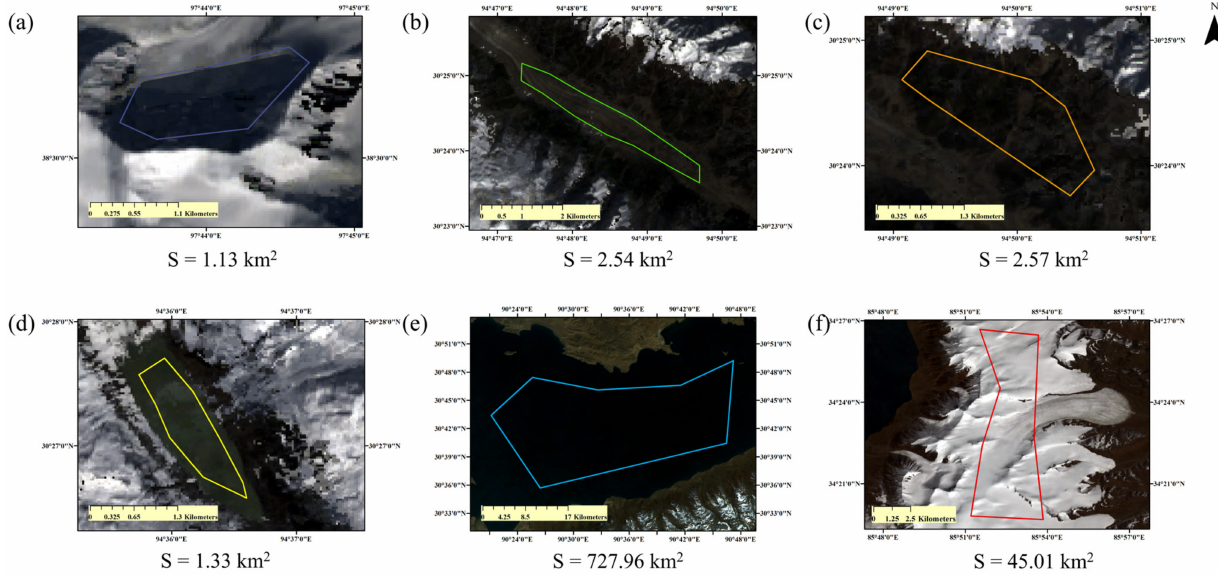
Figure 4. Sample collection of similar ground objects. ( a – f ) indicate shadow glaciers, debris-covered glaciers, rocks, glacial lakes, lakes, and clean glaciers, respectively. The S represents the area of each sampling